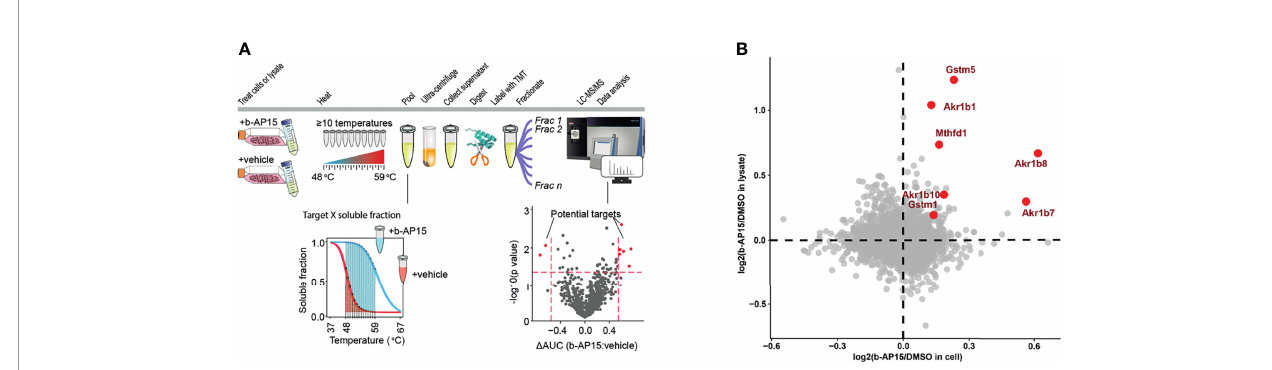
FIGURE 7 | PISA analysis. (A) Schematic representation for PISA in living cells and cell lysate. B16-F10 cells or native lysate is treated with b-AP15 or vehicle (DMSO) and 10 aliquots are obtained. Each aliquot is heated to a speci fi c temperature for 3 min. The aliquots corresponding to different temperature points are then pooled and centrifuged to collect the soluble fractions. The collected pools are then digested with trypsin, labeled with TMT and fractionated to extend the proteome coverage. The fractions are then subjected to LC-MS/MS and data is extracted and analyzed. The comparison of soluble fractions (area under the curve or AUC) for each protein in the presence and absence of the compound will highlight the drug targets. (B) The overlay of protein solubility in living cells vs. cell lysate highlights the proteins that are more soluble in the presence of b-AP15, indicating that they directly bind to the compound. P -values were calculated using a paired Student ’ s t -test (n=4). The highlighted proteins (red) have a p <0.05 in both living cell and lysate